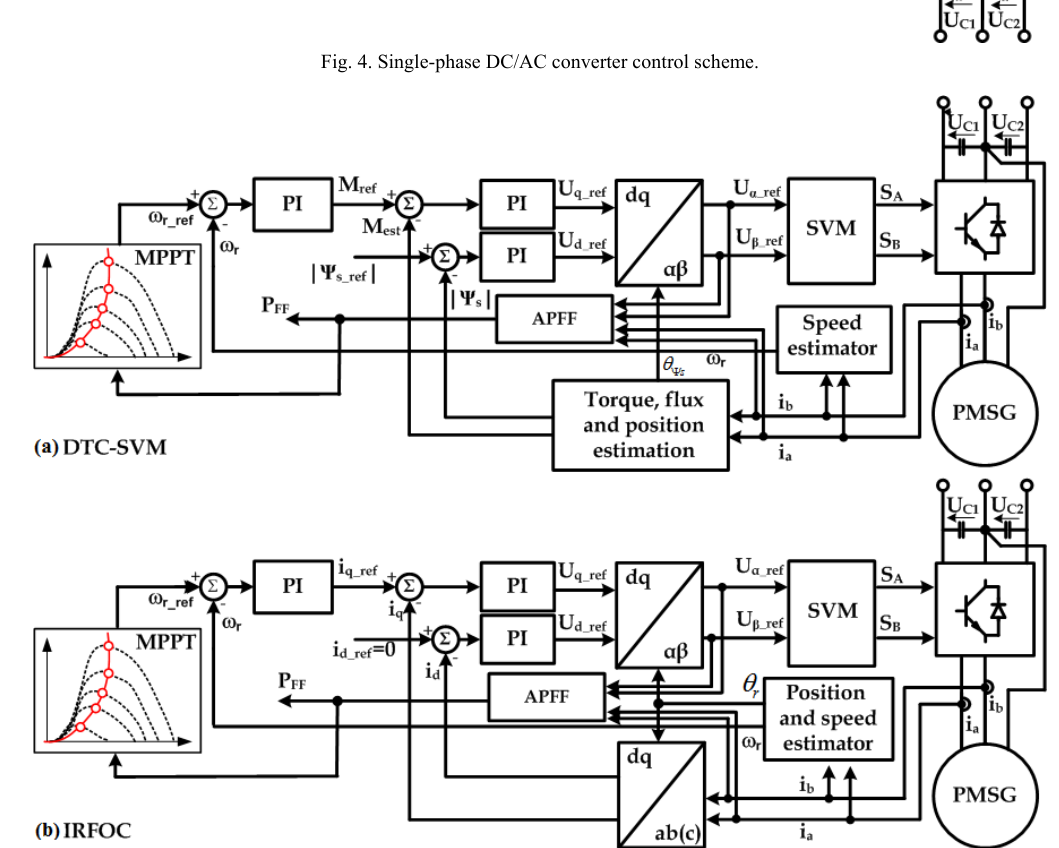
Fig. 5. Three phase AC/DC converter control schemes of DTC-SVM (a) and IRFOC